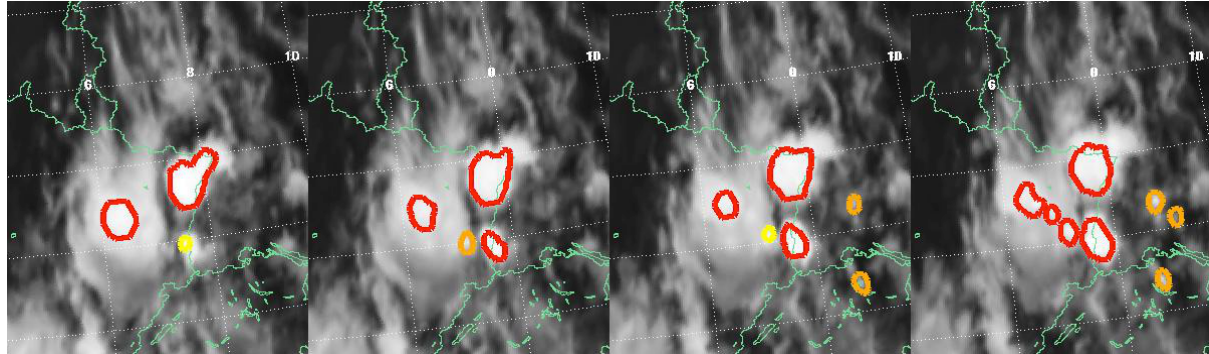
Fig. 6. Development of new thunderstorm cells in an orographic environment over the Black Forest and Jura Mountains in the night of 3 July 2010 between 22:30 and 23:15UTC. The plots show the cell objects as polygons in the same colours as in Cb-TRAM (yellow: CI; orange: rapid development; red: mature thunderstorm) on top of the IR10.8 satellite